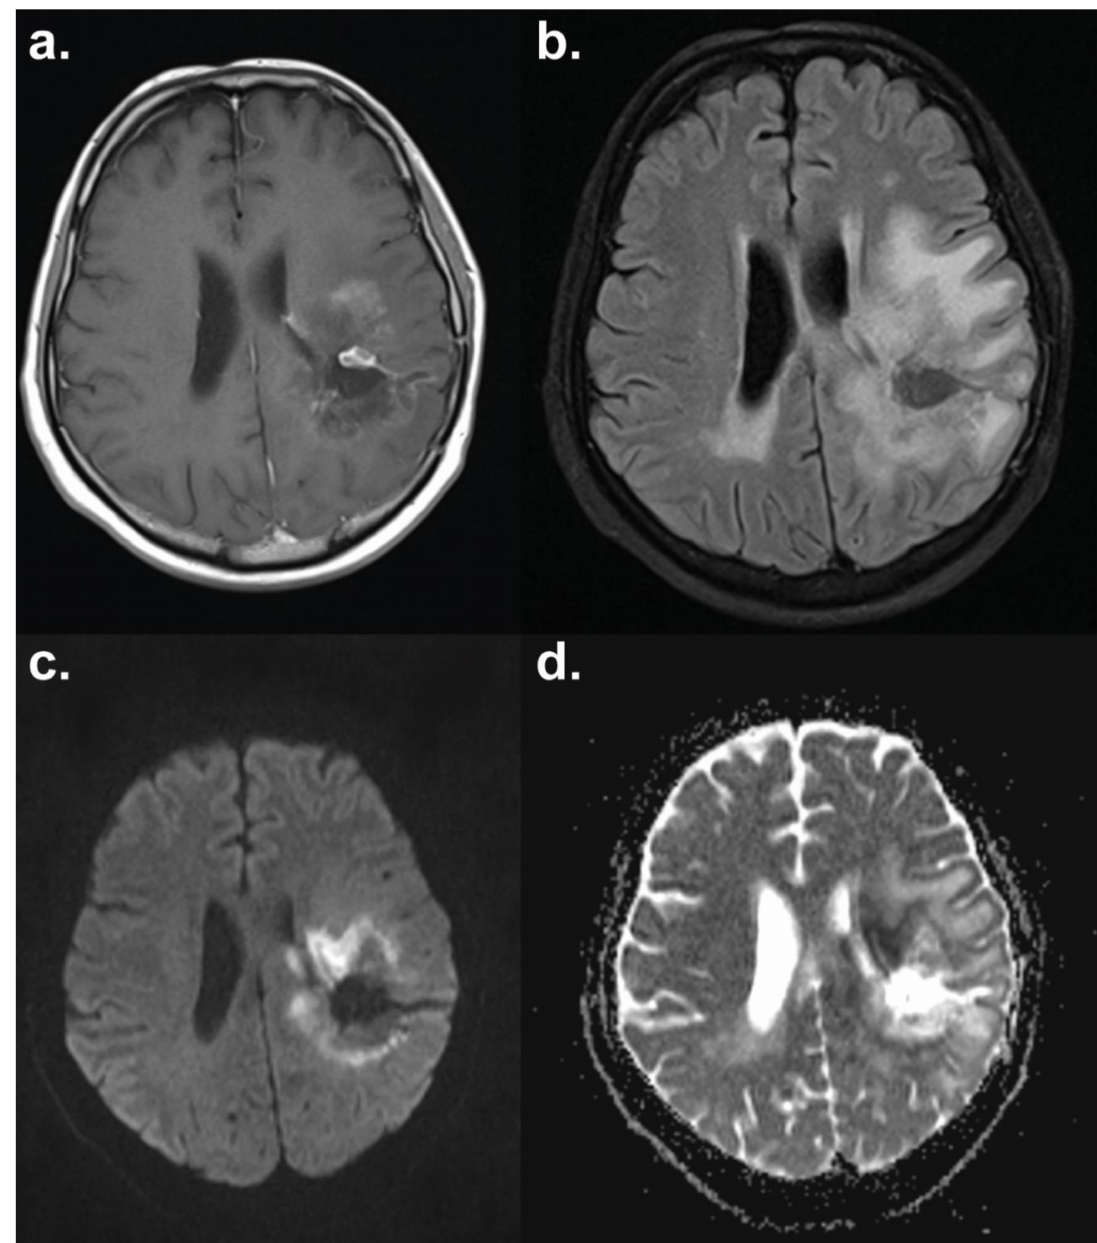
Figure 3. Diffusion-weighted MRI of a patient with glioblastoma multiforme. The necrotic core shows facilitated diffusion with a surrounding ring of restricted diffusion indicative of progressive disease. Axial sections have the following sequences: ( a ) T 1 -weighted contrast-enhanced; ( b ) T 2 FLAIR (fluid-attenuated inversion recovery); ( c ) diffusion-weighted imaging (DWI); ( d ) apparent diffusion coefficient (ADC) map. Images courtesy of Dr Harpreet Hyare, University College London